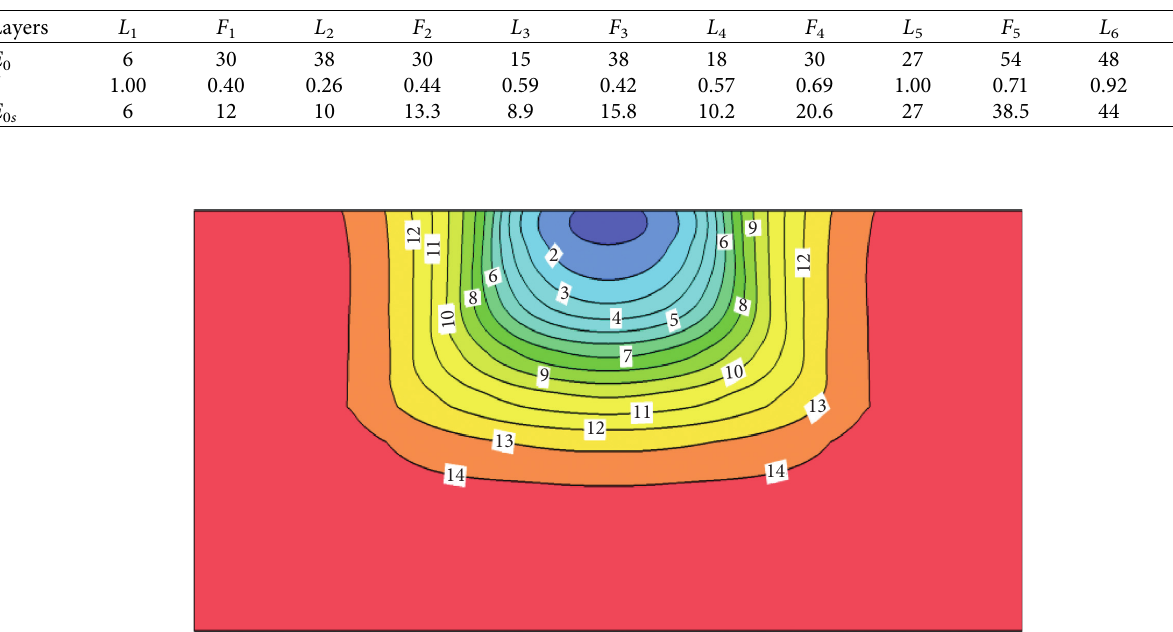
Table 7: Reduction of deformation modulus (unit: MPa).